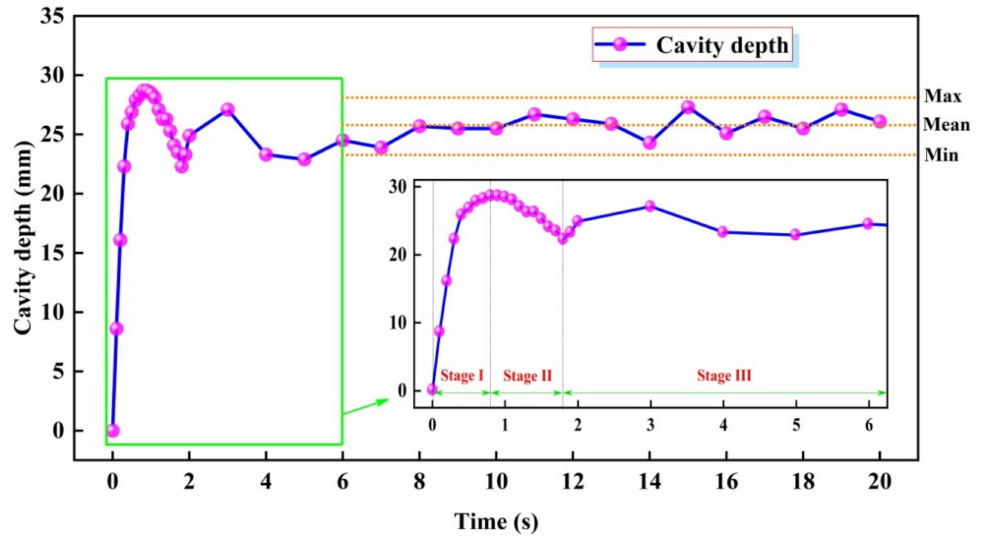
Figure 5. The cavity depth as a function of time in the unified model with an arc current of 10 kA and an arc length of 300